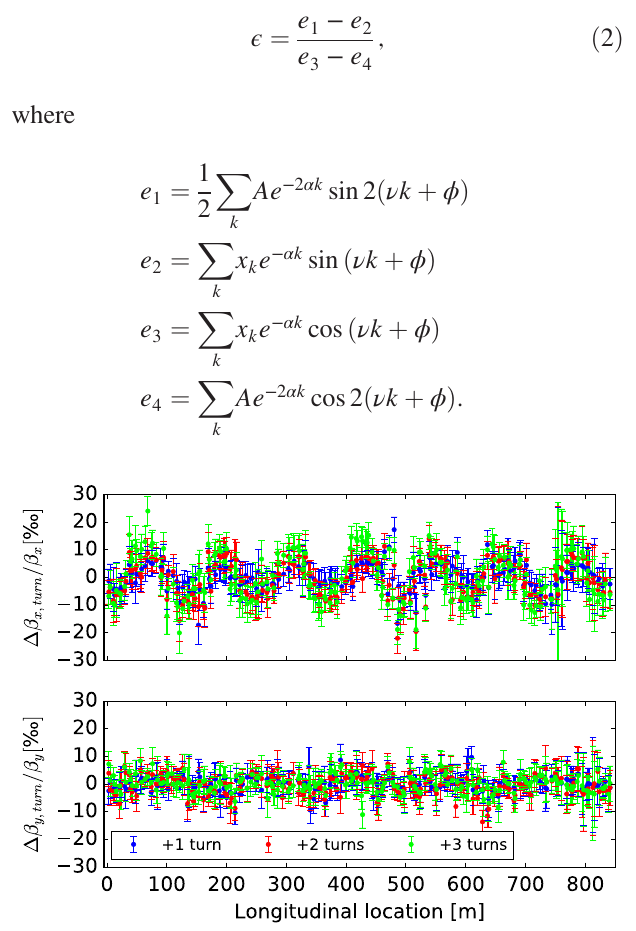
FIG. 6. Measured β -beating when analyzing the TbT data delayed by different number of